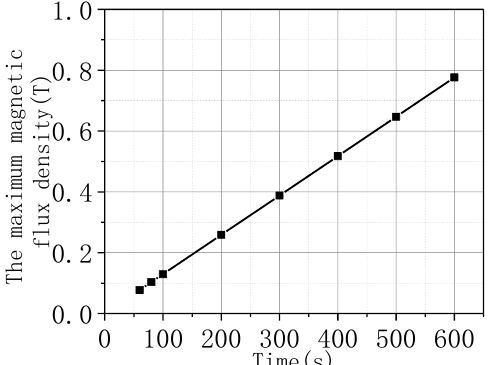
Figure 12. The maximum magnetic flux density value under different current amplitudes. Materials 2023 , 16 , x FOR PEER REVIEW 11 of 17